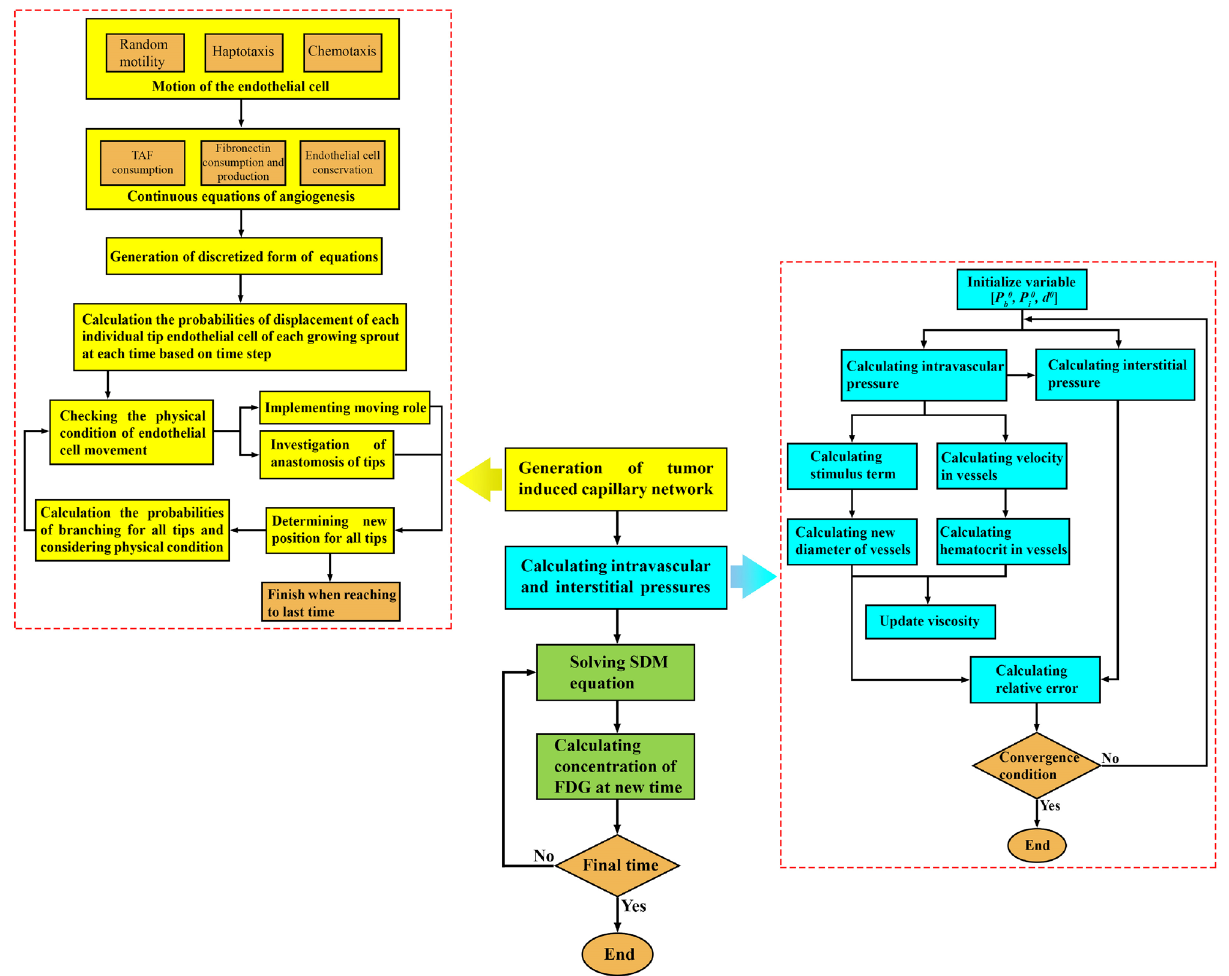
Figure 4. A step-by-step flowchart of the present multi-scale model (generation of the capillary network corresponds to one time